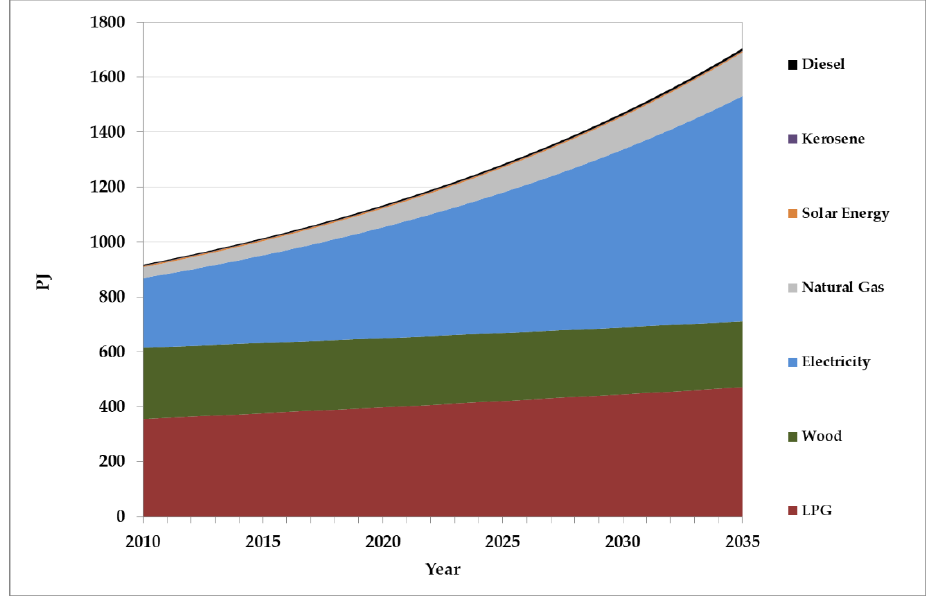
Figure 2. Energy consumption by source in the trend scenario for the RCPS sectors, 2010–2035. Source: Own elaboration.